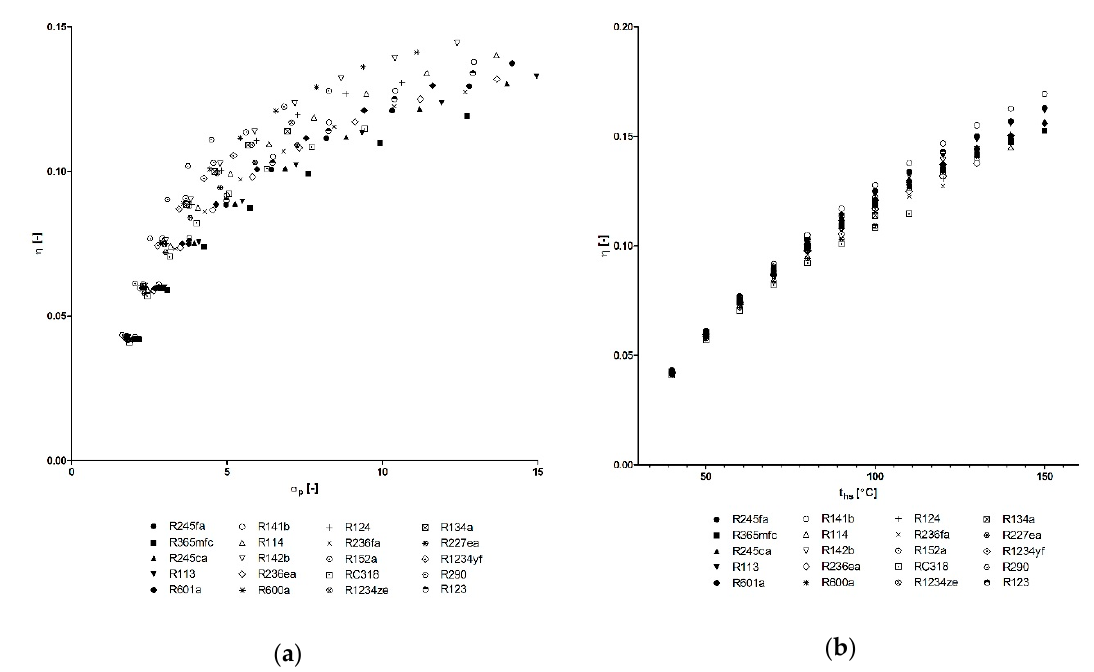
Figure 9. The variation of ORC system efficiency vs. pressure expansion ratio and heat source temperature: ( a ) η = f( σ P ); ( b ) η = f(t hs ).